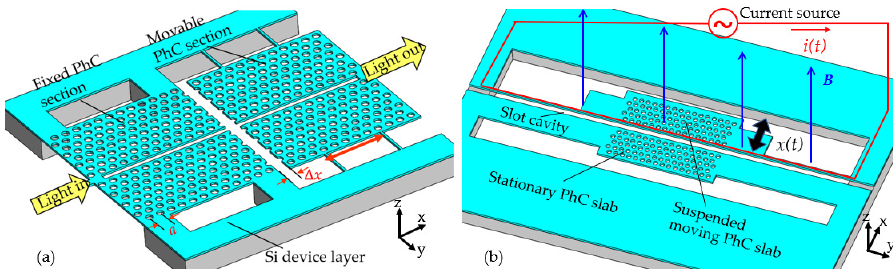
Figure 6. Schematics of the displacement sensors: ( a ) 2D-slot PhC with fixed and moving segments [9]; ( b ) schematic of the magnetic field sensor based on slot PhC slab cavity[13]. ( b ) schematic of the magnetic field sensor based on slot PhC slab cavity [13].